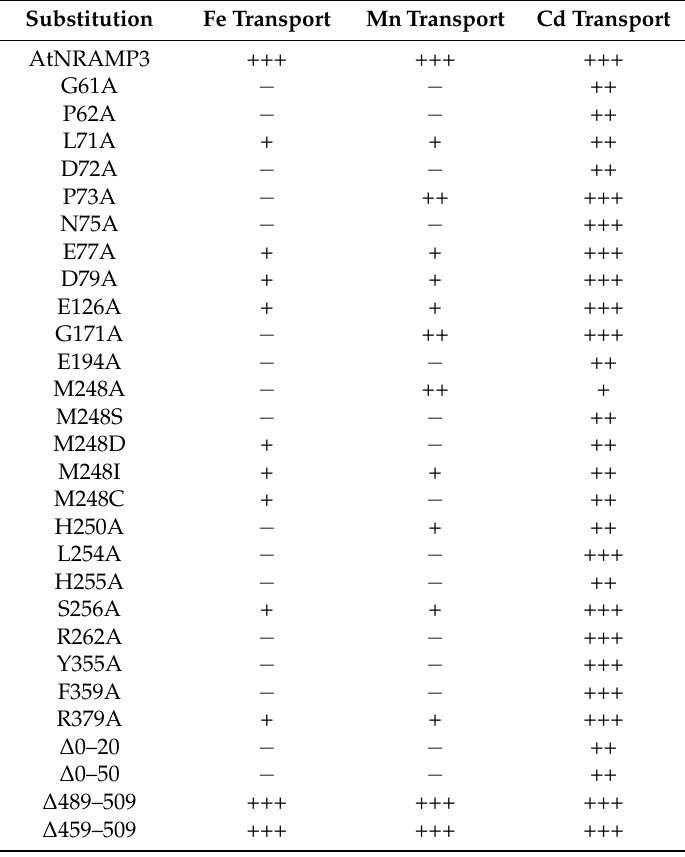
Table 1. Summary of the mutants that affect the transport activity of AtNRAMP3. The transport activity of wild-type AtNRAMP3. − , none; + or ++, partial; +++,